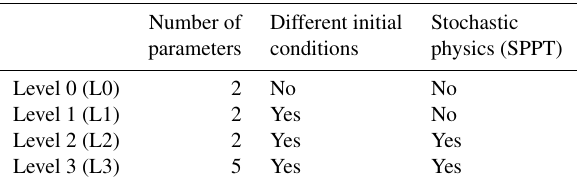
Table 2. Summary of convergence tests with different degrees of